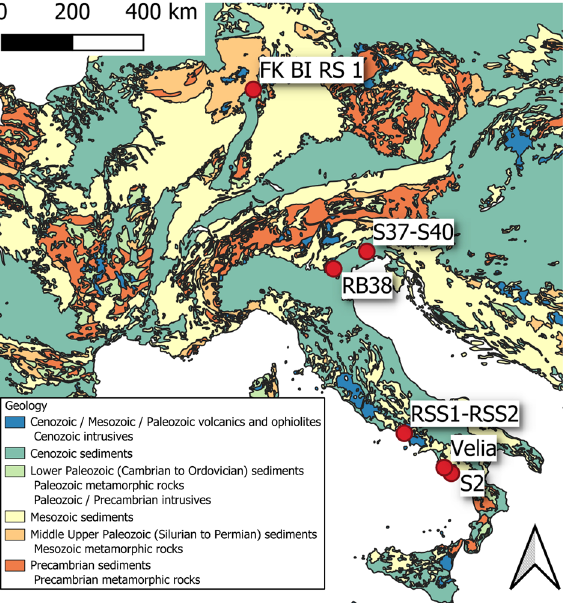
Figure 1. Excavation sites of the skeletal samples considered in this study. The simplified geological map has been drawn using QGIS 3.18 (https:// www. qgis. org/) by F.L., based on the geological map from 63 .